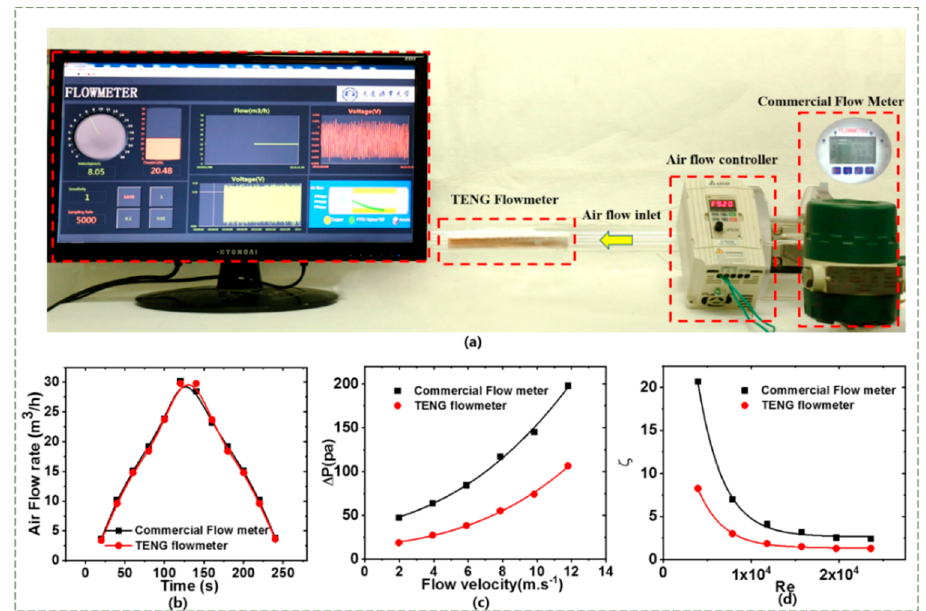
Figure 7. Demonstration of the TENG flowmeter for measuring real ‐ time flow rate. ( a ) Photos of the real ‐ time gas flow rate measurement using TENG flowmeter. ( b ) Comparison of TENG flowmeter and commercial gas flowmeter. ( c ) Pressure loss under di ff erent airflow velocities. ( d ) Pressure loss coefficient corresponding to Reynolds number.